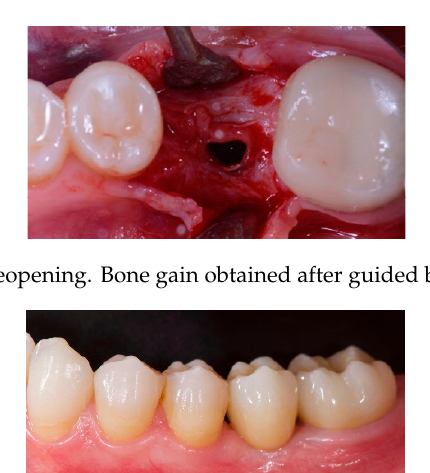
Figure 5. Definitive prosthesis delivery.